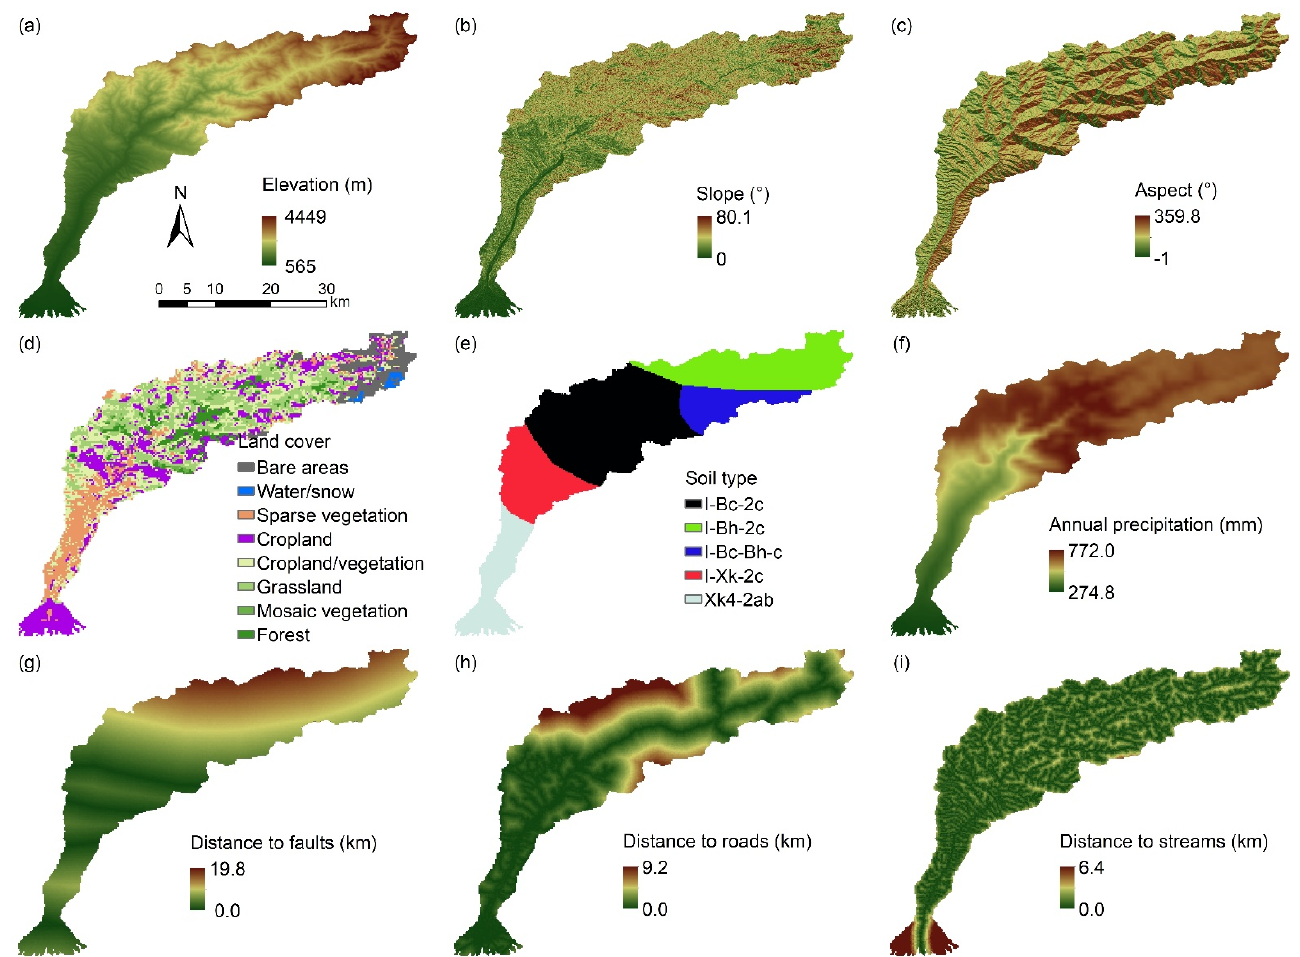
Figure 5. Distributions of variables selected for the correlation analysis in the Mailuu-Suu catchment: ( a ) elevation, ( b ) slope, ( c ) aspect, ( d ) land cover, ( e ) soil type, ( f ) annual precipitation between 1970 and 2000, distance to ( g ) faults, ( h ) roads, and ( i ) streams.